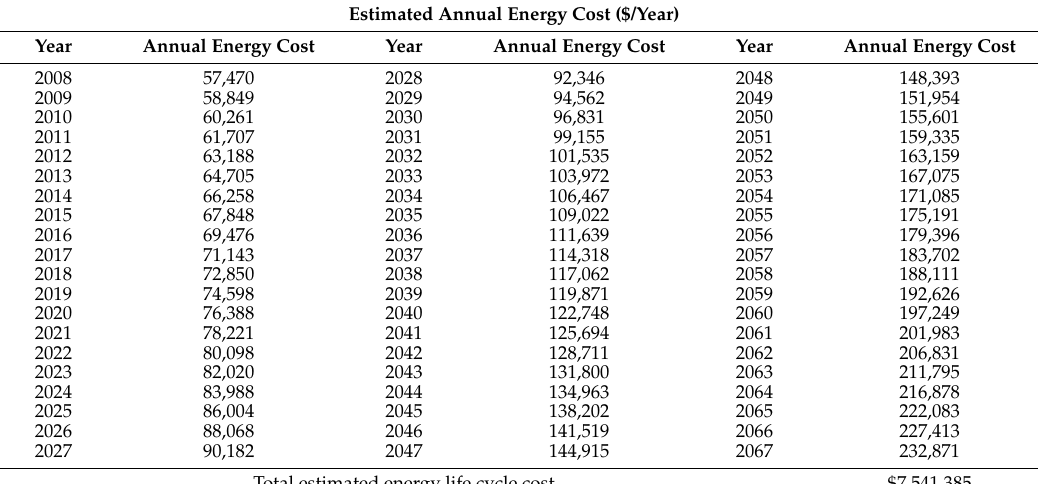
Table 3. Estimated life cycle cost of energy for the case study (2008 as base